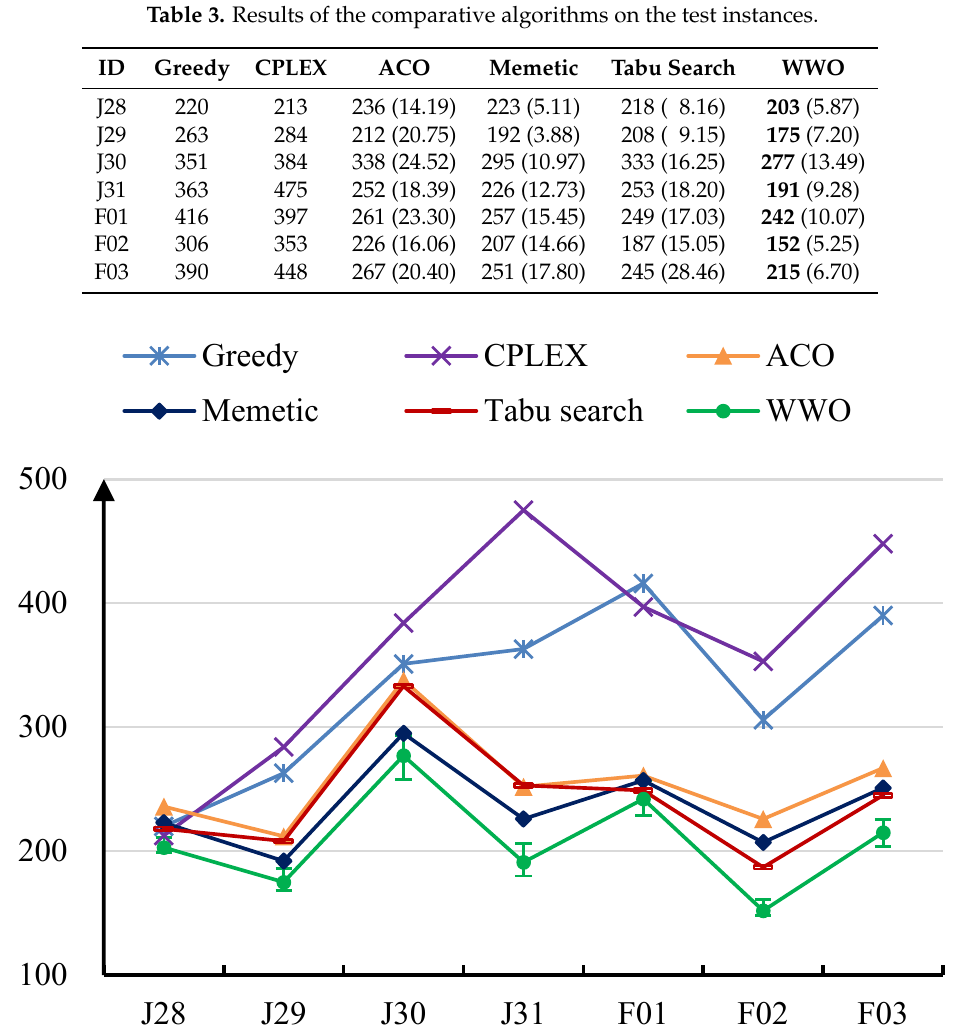
Figure 3. Comparative results of the algorithms on the test instances. The horizontal axis denotes the test instance, and the vertical axis denotes the average exposure time (in